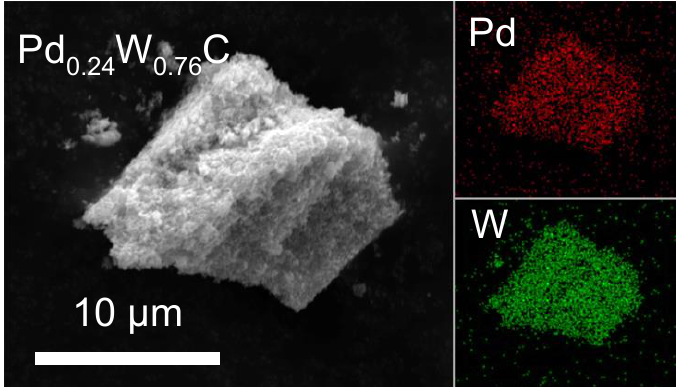
Figure 2. SEM of Pd-W cubic ternary carbide annealed to 850 °C with 24% Pd. The elemental mapping of these particles shows uniform Pd (red) and W (green).